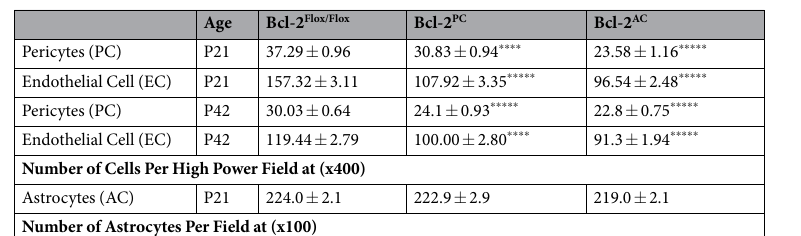
Table 1. Retinal Vascular Cell Numbers. The P values were calculated by comparing samples from Bcl-2 Flox/Flox to Bcl-2 PC or Bcl-2 AC mice at the ages noted: * P < 0.05; ** P < 0.01; *** P < 0.001; **** P < 0.0001; and ***** P <